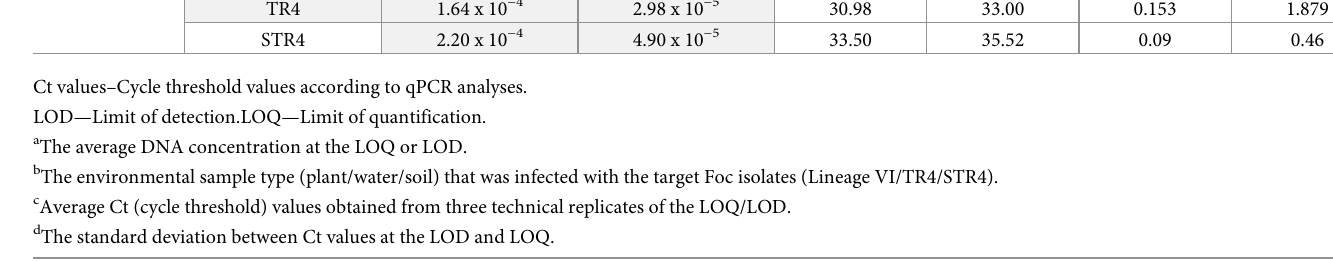
Ct values–Cycle threshold values according to qPCR analyses. LOD—Limit of detection.LOQ—Limit of quantification. a The average DNA concentration at the LOQ or LOD. b The environmental sample type (plant/water/soil) that was infected with the target Foc isolates (Lineage VI/TR4/STR4). c Average Ct (cycle threshold) values obtained from three technical replicates of the LOQ/LOD. d The standard deviation between Ct values at the LOD and